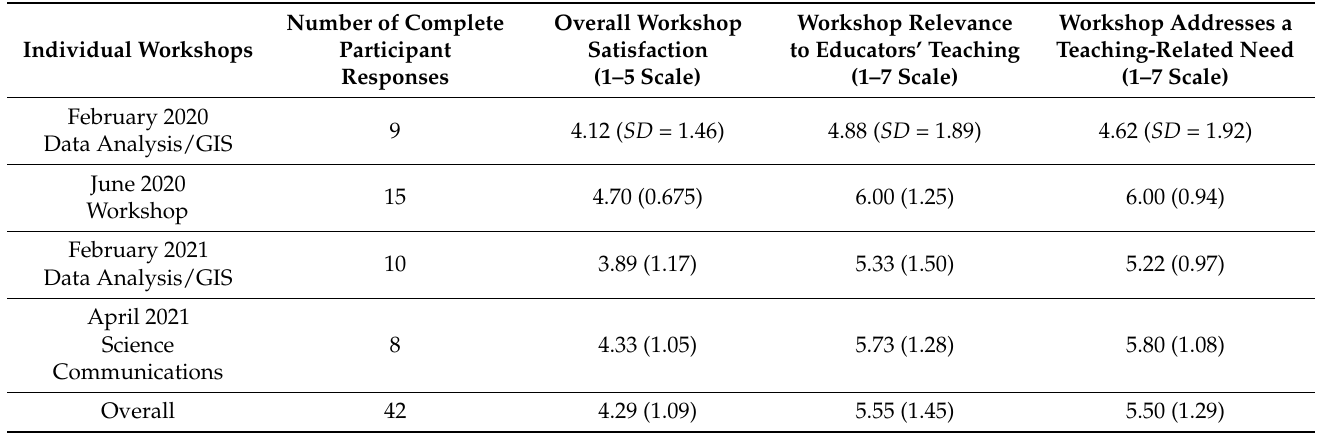
Table 1. To evaluate each workshop, educators completed surveys and overall, educators were satisfied with each